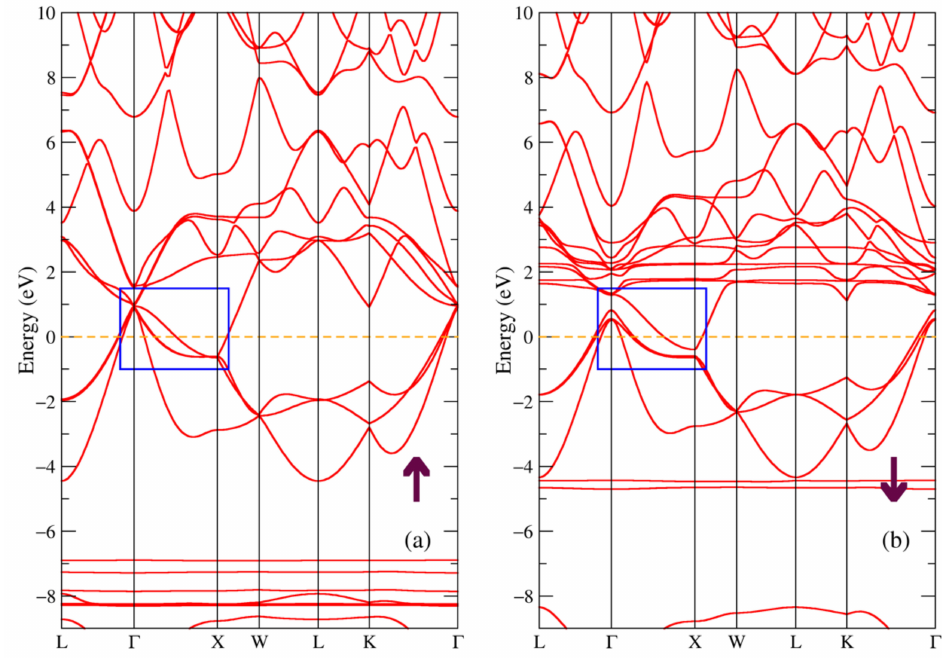
Figure 7. Band structure of DySb: ( a ) majority and ( b ) minority spin